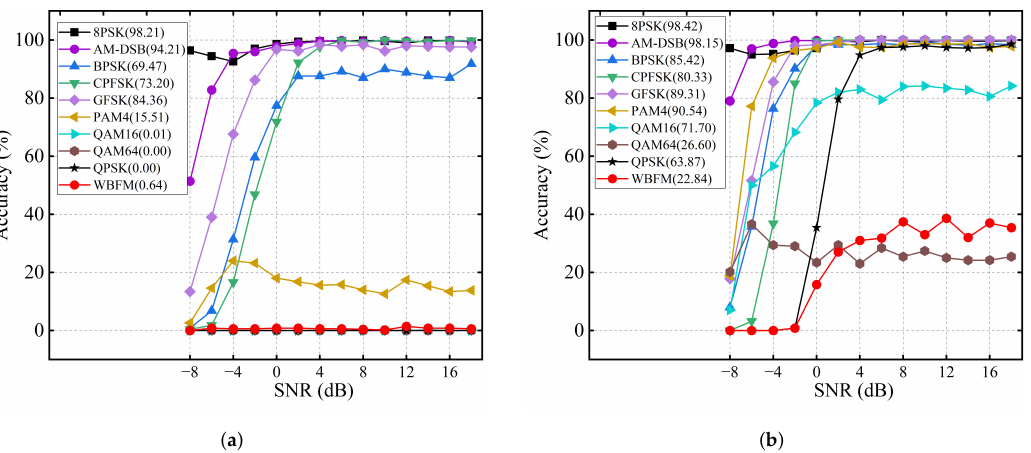
Figure 9. Recognition accuracy (%) of the ( a ) LSTM2 and ( b ) LSTM2 with SigAugment-R on the 2016A-50 dataset for each modulation class, with the values in parentheses in the legend representing the average recognition accuracy for each class across all SNRs.